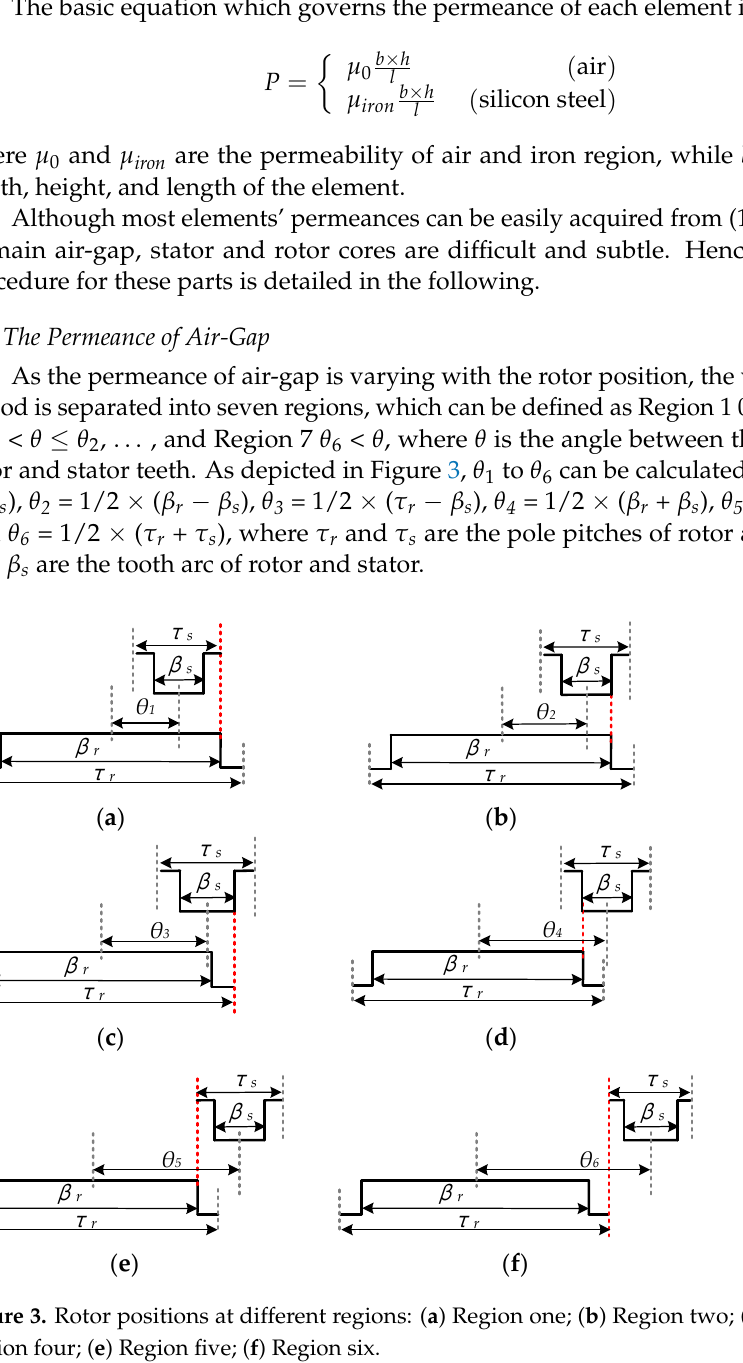
Figure 4. Relationship between air-gap permeance and rotor position. 3.2. The Permeance of Tooth, Yoke, and Consequent-Yoke Figure 5a,b show the field distribution of the stator and rotor core separately. In order to analyze these two iron regions, the stator is separated as stator tooth (including P TS1 and P TS ), stator yoke, and stator consequent-yoke, so that the corresponding magnetic field distributions can be seen as radial, circumferential, and axial directions, respectively [22]. Similarly, the magnetic field distributions in the rotor tooth, rotor yoke, and rotor conse- quent-yoke are separated in accordance with the relevant parts of the stator. To separate the stator and rotor core preciously, the widths of P CR and P CS , as well as the lengths of P YR and P YS , are specified based on FEM [18], and change dynamically with field current. But it should be mentioned that the FEM simulation only needs to run a few angles to get the widths of P CR and P CS , thus the time can be saved. Then, as the magnetic field distribution in each element is simplified as one-directional [23], (1) can be employed to calculate the P TR , P YR , P CR , P TS1 , P TS , P YS , and P CS .